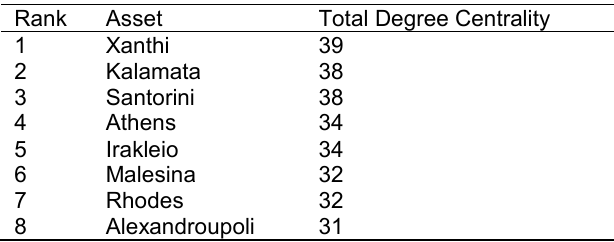
Table 2. Sample total degree centrality Table 3. Sample total degree centrality with new